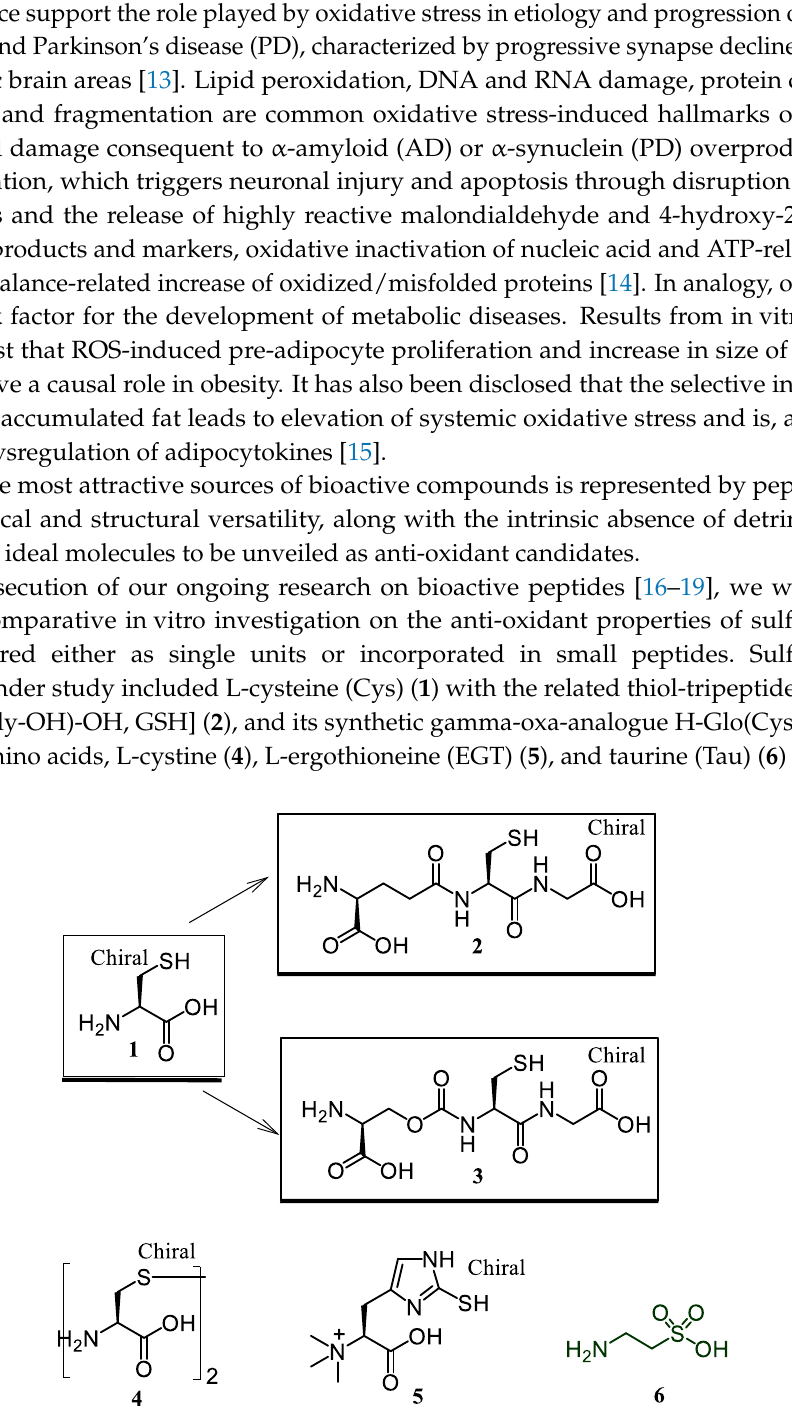
Figure 1. Chemical structures of sulfurated compounds 1 – 6 .